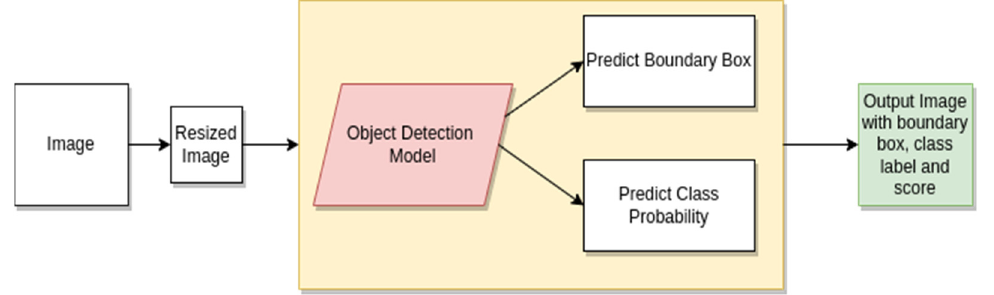
Figure 2. Traditional Flow Chart for Malaria Localization.